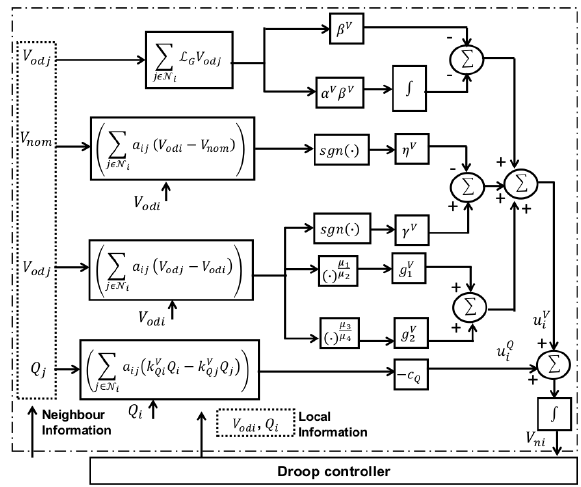
Figure 2. Block diagram of proposed distributed finite-time secondary voltage and reactive power regulation